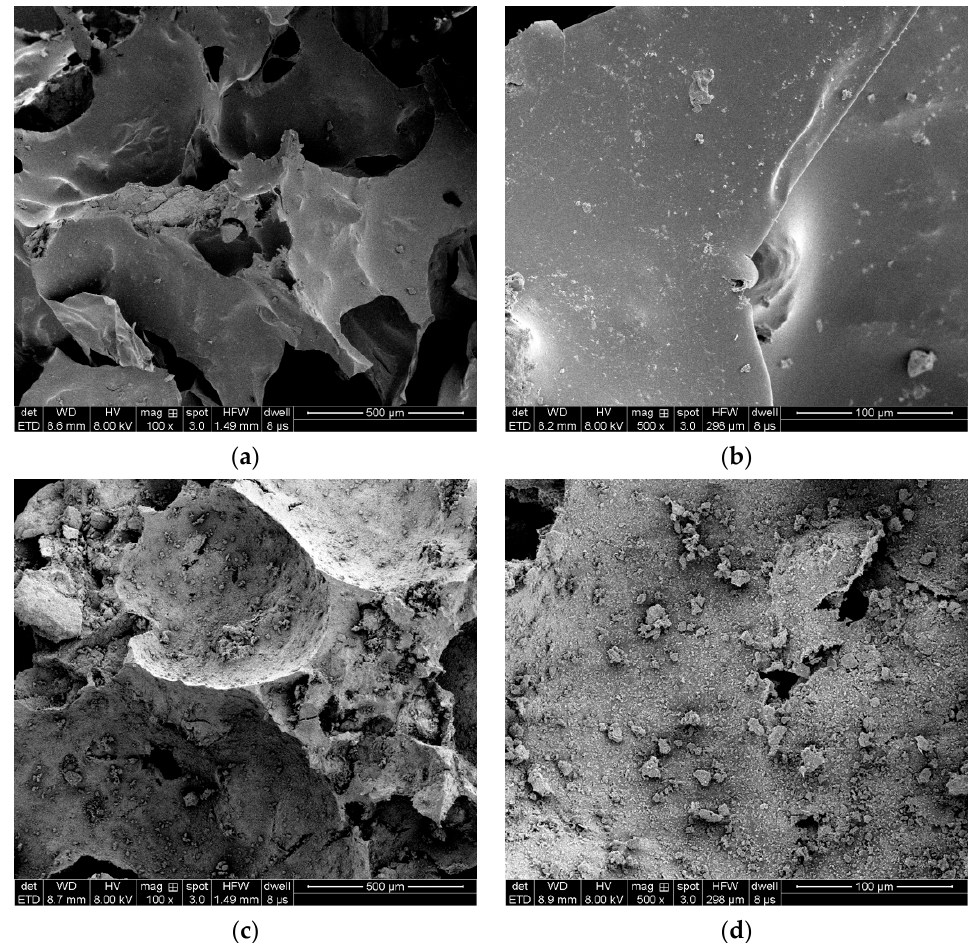
Figure 2. FTIR of PU-AL and alum sludge.